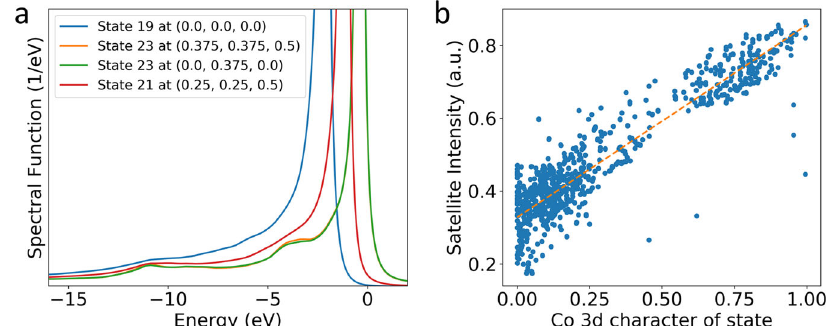
Fig. 5 Analysis on the origin of the satellite peak in the VB spectra. a Selected GW + C spectral functions that contribute strongly to the satellite intensity between 10 and 11 eV below the Fermi level in the theoretical photoelectron spectrum of PdCoO 2 . b Analysis of valence band spectral functions in PdCoO 2 . The scatter plot demonstrates the correlation between the intensity of the satellite 10 eV below the quasiparticle peak and the Co 3 d character of the valence state. The correlation is also demonstrated by the linear fi t (the orange